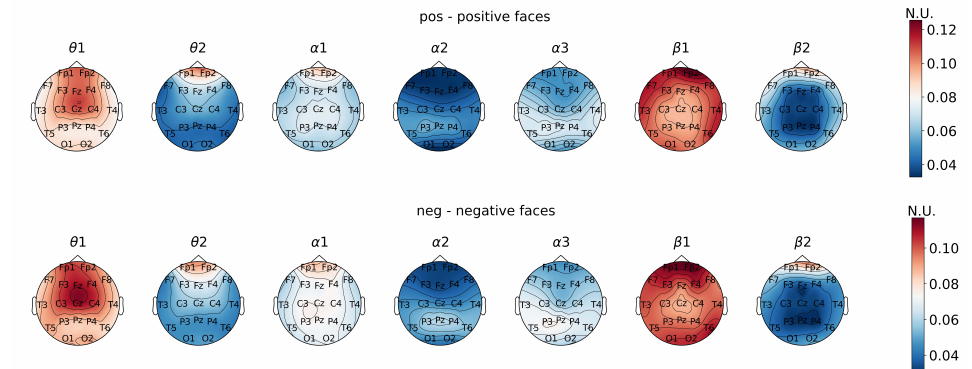
Figure 1. Topographic distribution of PSD values during the perception of positive and negative